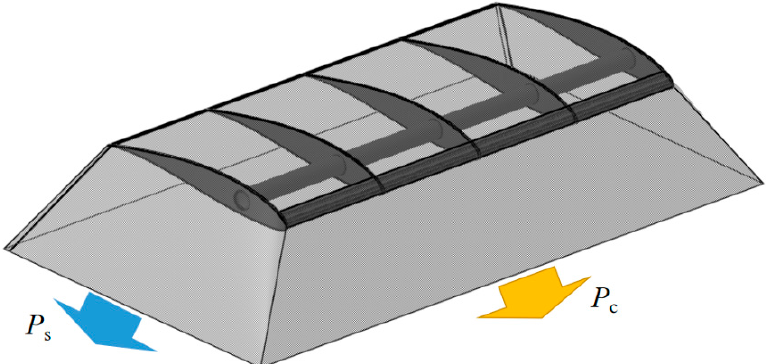
Figure 26. Spanwise and chordal prestress of membrane skin.